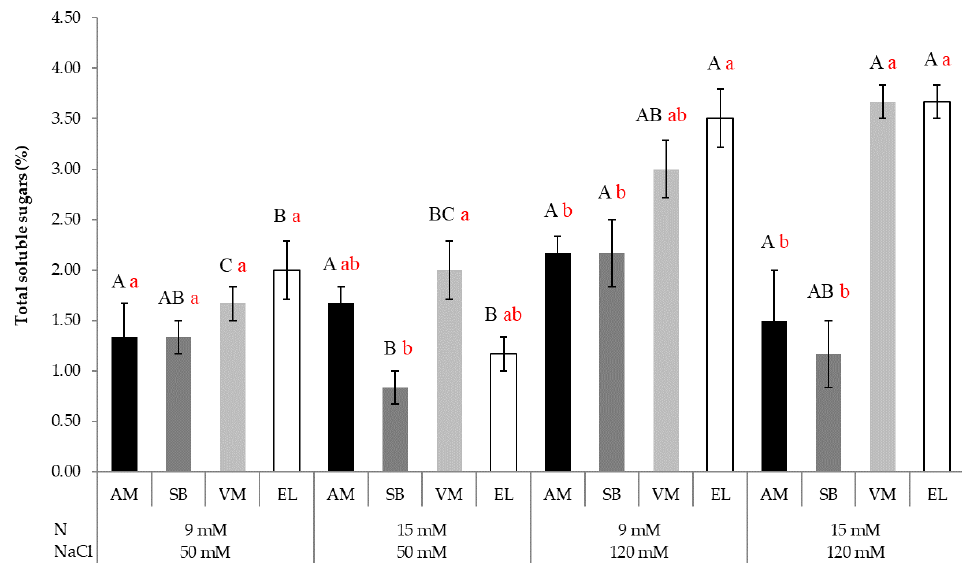
Figure 5. Total soluble solids Arthrocnemum macrostachyum (AM), Salicornia brachiata (SB), and Sarcocornia fruticosa ecotypes (EL and VM). LN under different combinations of N (9 and 15 mM) and NaCl (50 and 120 mM). Means plus standard errors ( ± SE) are shown. Different uppercase letters show significant differences between treatments of one ecotype (same color bars), and different lowercase red letters show significant differences between ecotypes within the same treatment (Tukey’s HSD, p ≤ 0.05, n = 3).